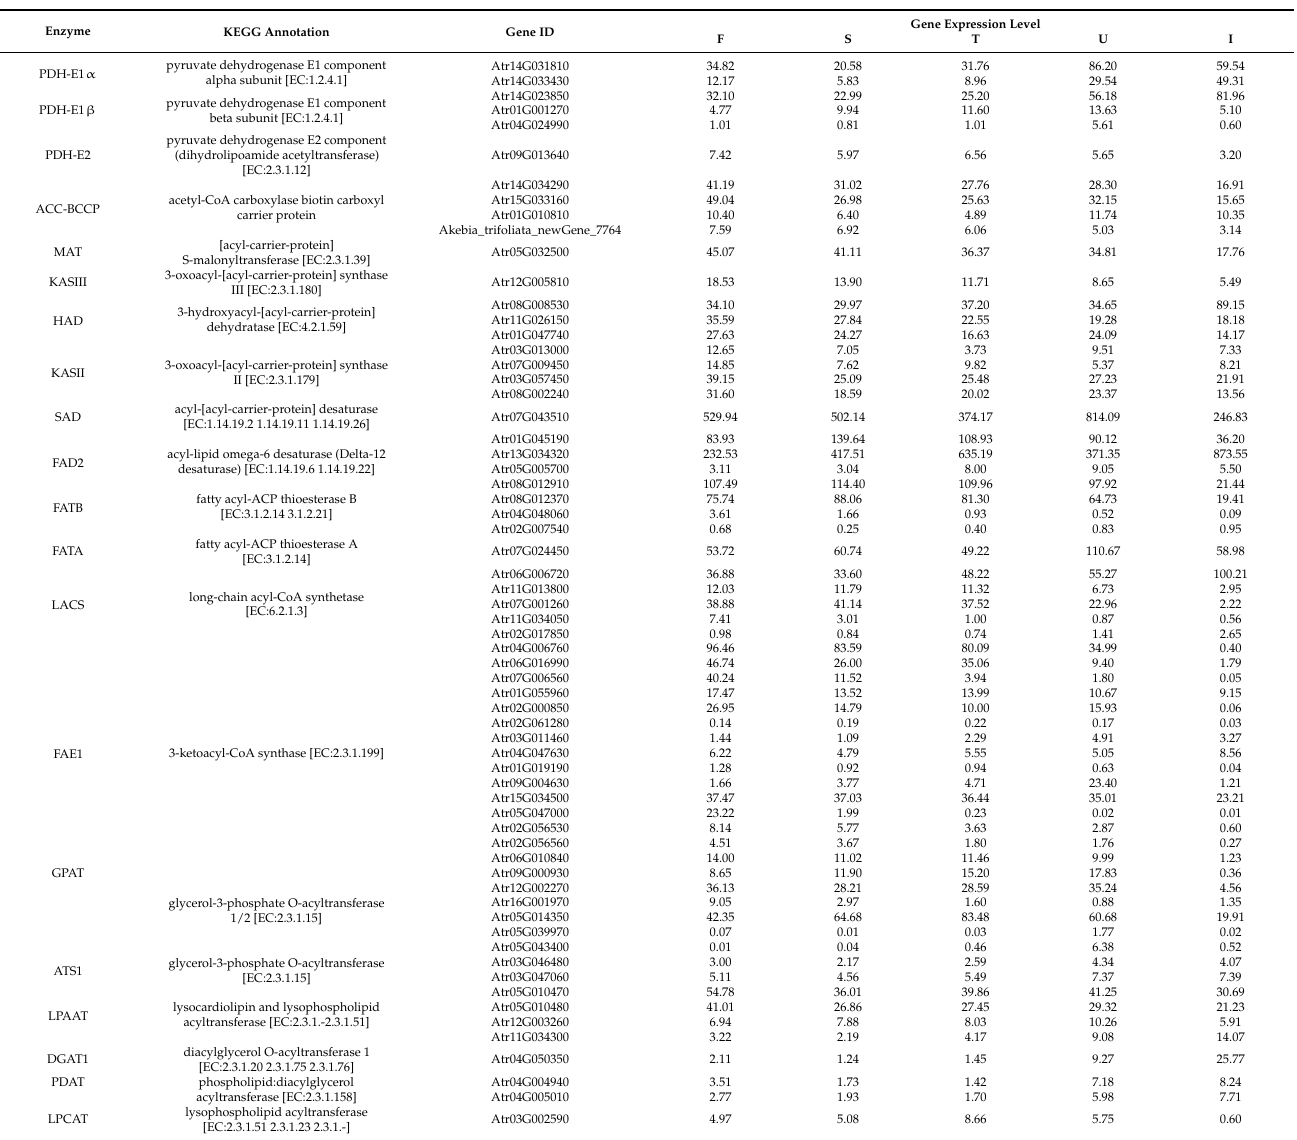
on the hidden Markov model. Through Pfam domain analysis, 20 FAD family genes were ultimately obtained and numbered according to their annotation in A. trifoliata (Table 3). Table 2. Identification of lipid-related genes in developing